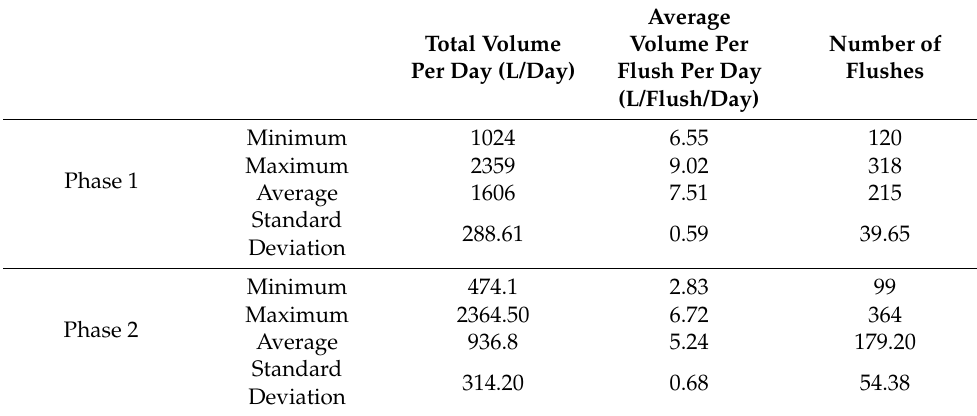
Table 1. Summary of Phases 1 and